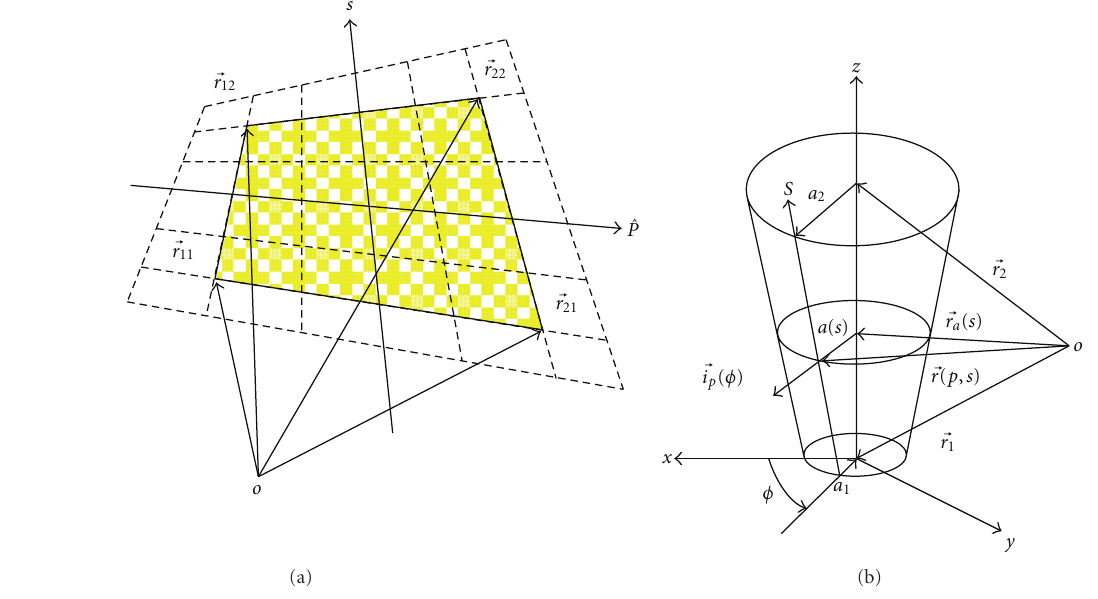
Figure 1: Geometric model: (a) a bilinear surface defined by four vertices; (b) a right-truncated cone defined by position vectors and radii of its beginning and